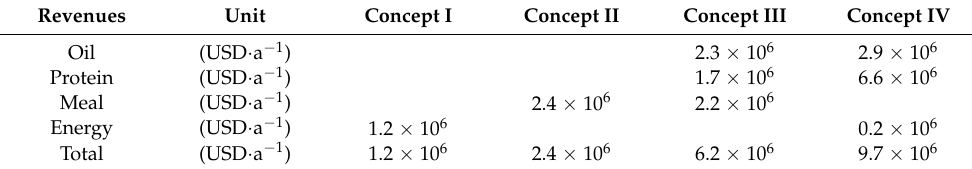
Table 8. Revenues.